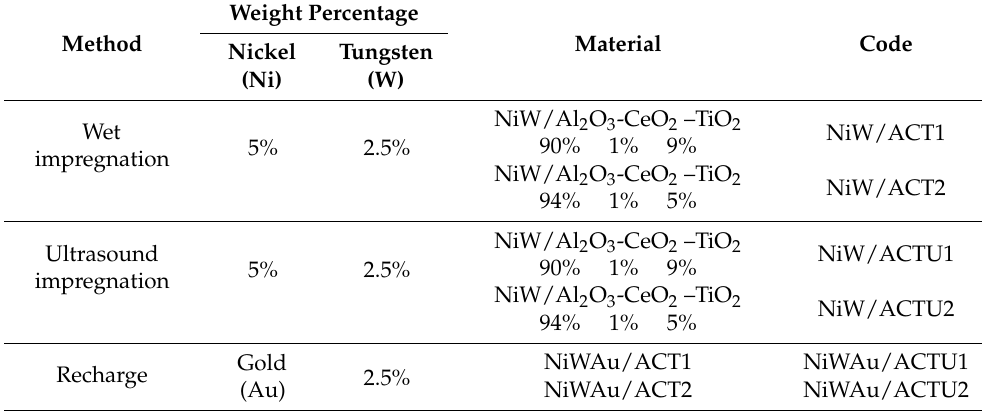
Figure 1. Synthesis system for the preparation of NiWAu/Al 2 O 3 -CeO 2 -TiO 2 nanomaterials by recharge method. Table 1. Nanomaterials synthesized by the wet impregnation, ultrasound and recharge